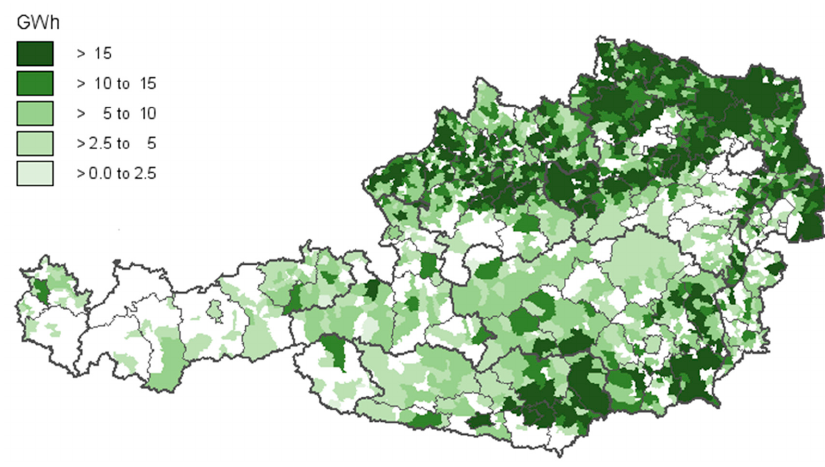
Figure 1. Spatial distribution of the technical biogas potential (own analysis).